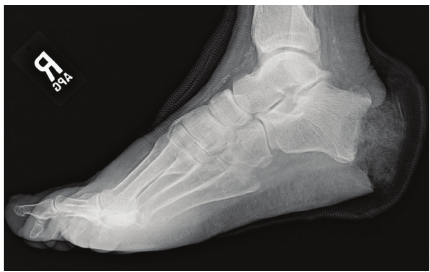
Figure 5: Category 1 partial calcanectomy.